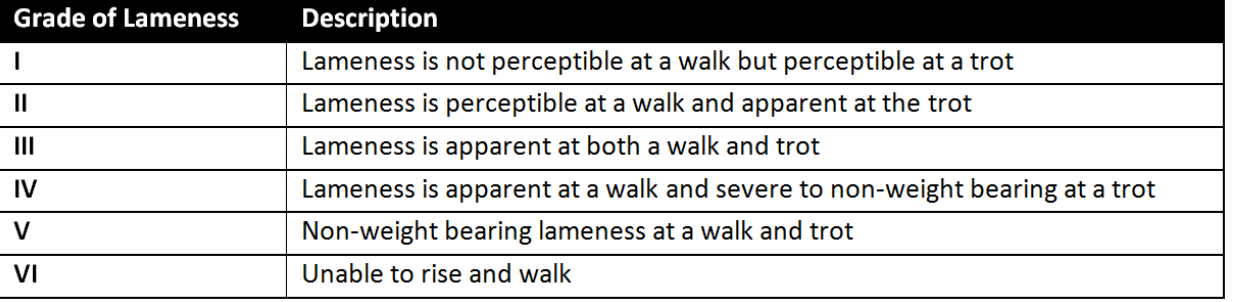
Table 2 : Lameness Numeric Rating